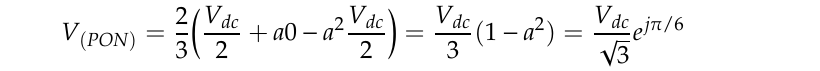
Figure 4. Voltage vector depending on the switching state: ( a ) PPP; ( b ) OOO; ( c ) NNN; ( d ) POO; ( e ) ONN; ( f ) PON.